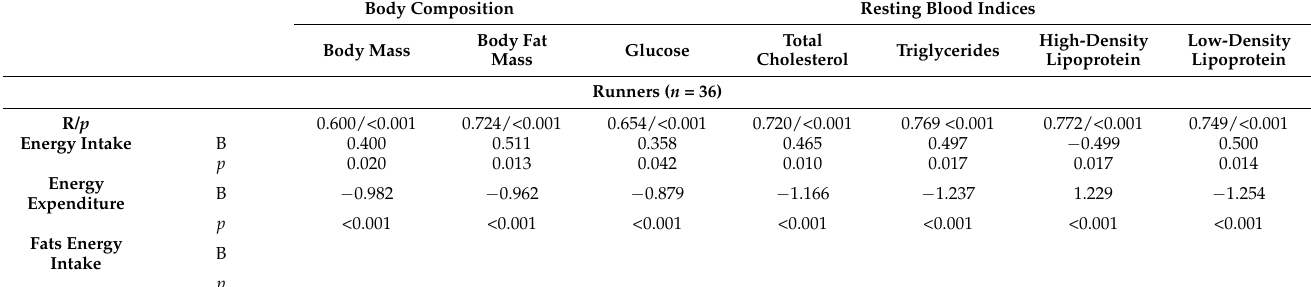
Table 3. Beta coefficients (B) as indicators of the selected predictors’ relative strengths/impact on body, fat masses, blood glucose, total cholesterol, triglycerides, High-density lipoprotein (HDL-C), Low-density lipoprotein, in each group separately. Body Composition Resting Blood Indices Body Mass Body Fat Mass Glucose